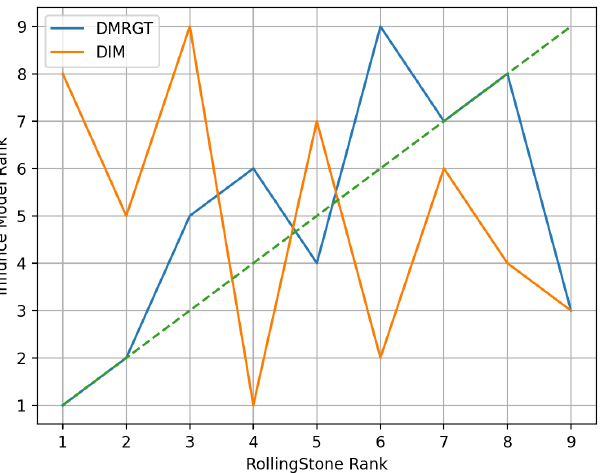
Figure 10. Ranking comparison between DMRGT algorithm based on Rolling Stone ranking and DIM